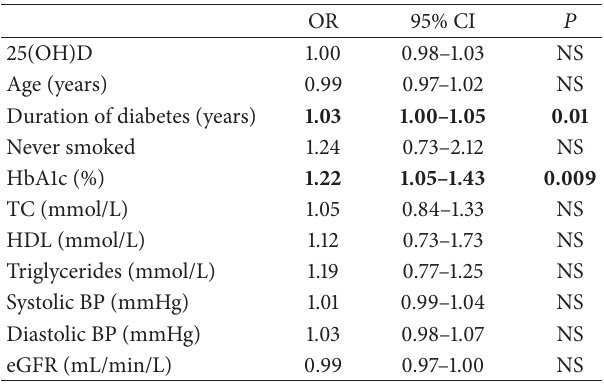
BMI:BodyMassIndex,BP:bloodpressure,TC:totalcholesterol,HDL:high- density lipoprotein cholesterol, ALP: alkaline phosphatase, CCa: corrected calcium, and eGFR: estimated glomerular filtration